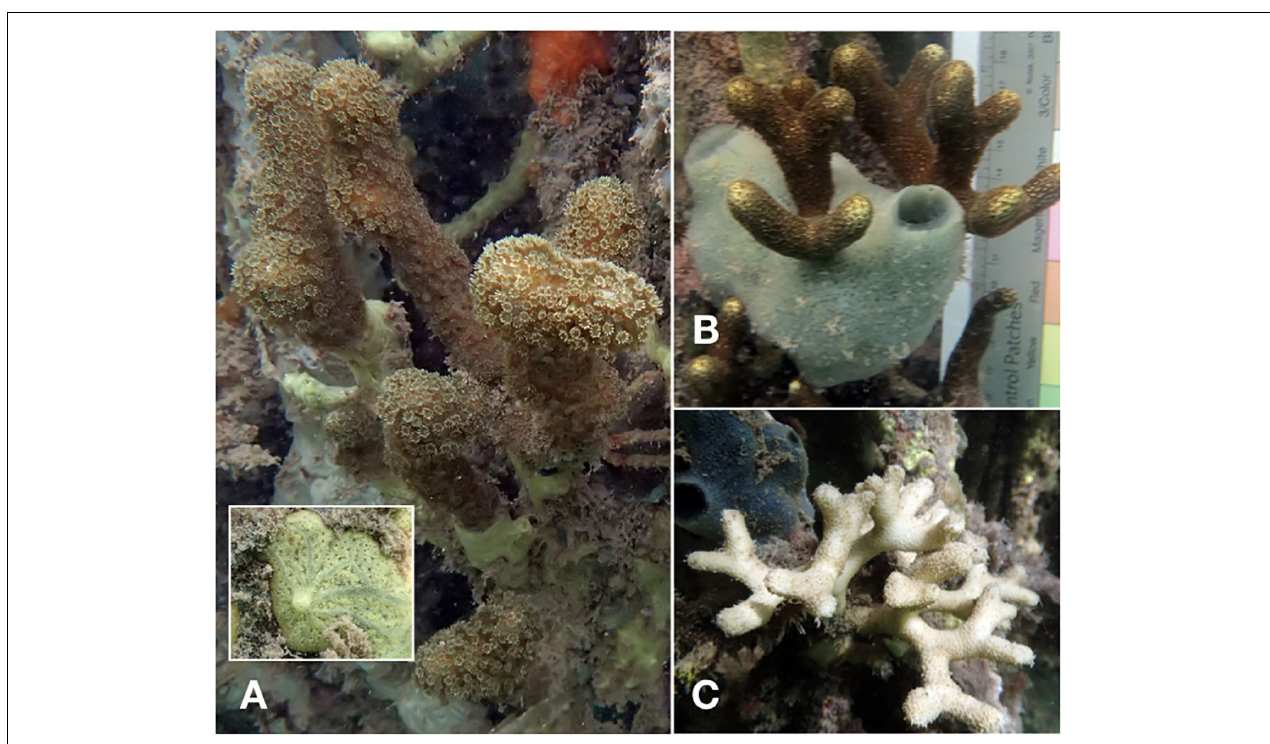
FIGURE 4 | Representative colonies exhibiting partial or complete mortality. Overgrowth of P. divaricata by sponges (A,B) . Based on the grayish canals, which radiate from the protruding oscules, the yellow sponge in panel (A) appears to be Clathria venosa Alcolado 1984 (Collin et al., 2005; Diaz and Rützler, 2009). This encrusting species has previously been recorded on mangroves prop roots in Belize, Cuba and Panama (Diaz and Rützler, 2009). The turquoise sponge in panel (B) is possibly Lissodendoryx isodictyalis , a shallow-water mangrove sponge that is known to overgrow Porites (Laubenfels, 1950; Rutzler et al., 2007). Further analyses (e.g., characterization of spicules and DNA sequences) will be required to confirm species identity. An apparently intact skeleton lacking any live coral tissue is shown in panel (C)